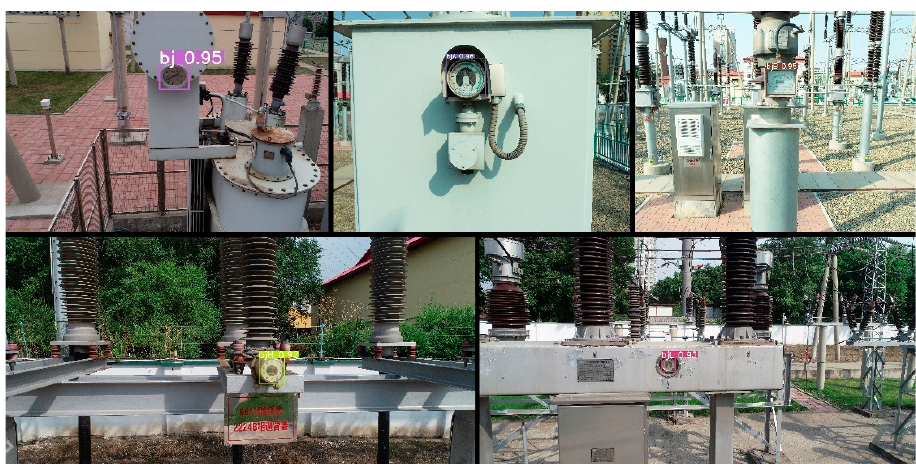
Figure 6. Dial detection results using YOLOv5s.